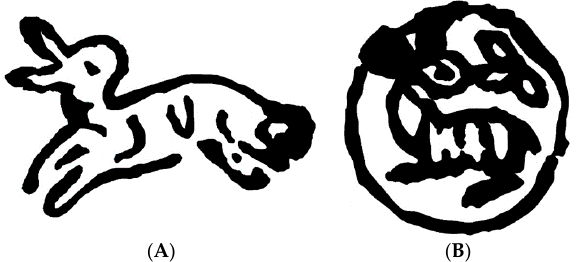
Figure 8. ( A ) A Song Yuan Huaya with a Hare motif. The period of the Song and Yuan Dynasties. Inventory number: 0690. Sketched by author. Picture source: Wen (1995), p. 198. The original collection: Bochuan, Huang. Zun Gu Zhai Ji Yin [ 《尊古齋集印》 ]. Book of impressions. ( B ) A Song Yuan Huaya with a Hare motif. The period of the Song and Yuan Dynasties. Inventory number: 0702. Sketched